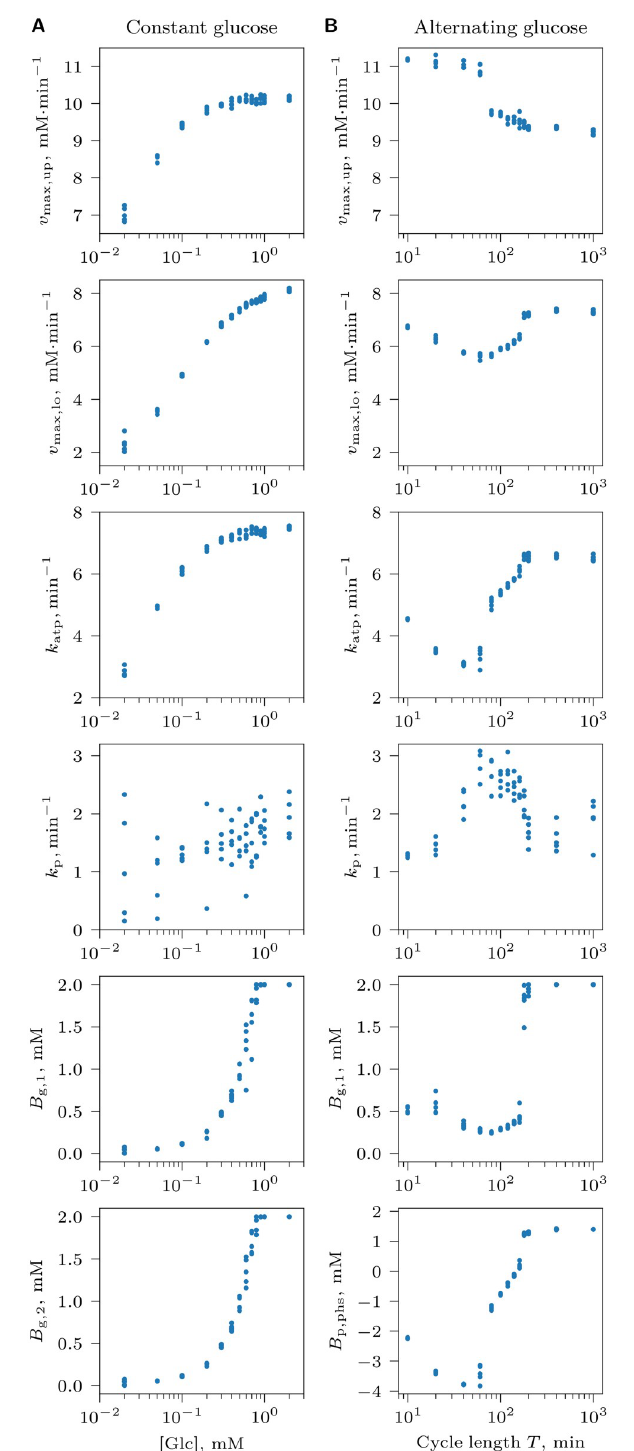
Fig 2. Optimization of the core glycolysis pathway in the absence of competition for glucose under NCG conditions with (A) a constant glucose supply concentration [Glc] 0 , or (B) an alternating glucose availability consisting of ON ([Glc] 0 = 2 mM) and OFF ([Glc] 0 = 0.01mM) phases of equal duration with period T = T on + T off . Each dot represents the average of an evolving genotype parameter ( v max,up , v max,lo , k atp and k p ) or a measure of balancedness at the end of an evolutionary simulation ( t e ). Genotype parameter averages were computed over the entire population of cells;